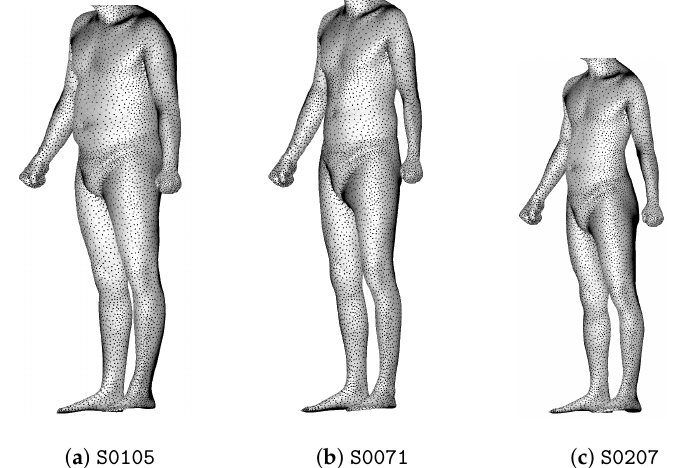
Figure 6. Individuals ( a – c ) are 1.89 m, 1.93 m and 1.65 m tall, respectively. Among them, the couple ( a , b ) is the closest before normalization, and the couple ( b , c ) is the closest after normalization.